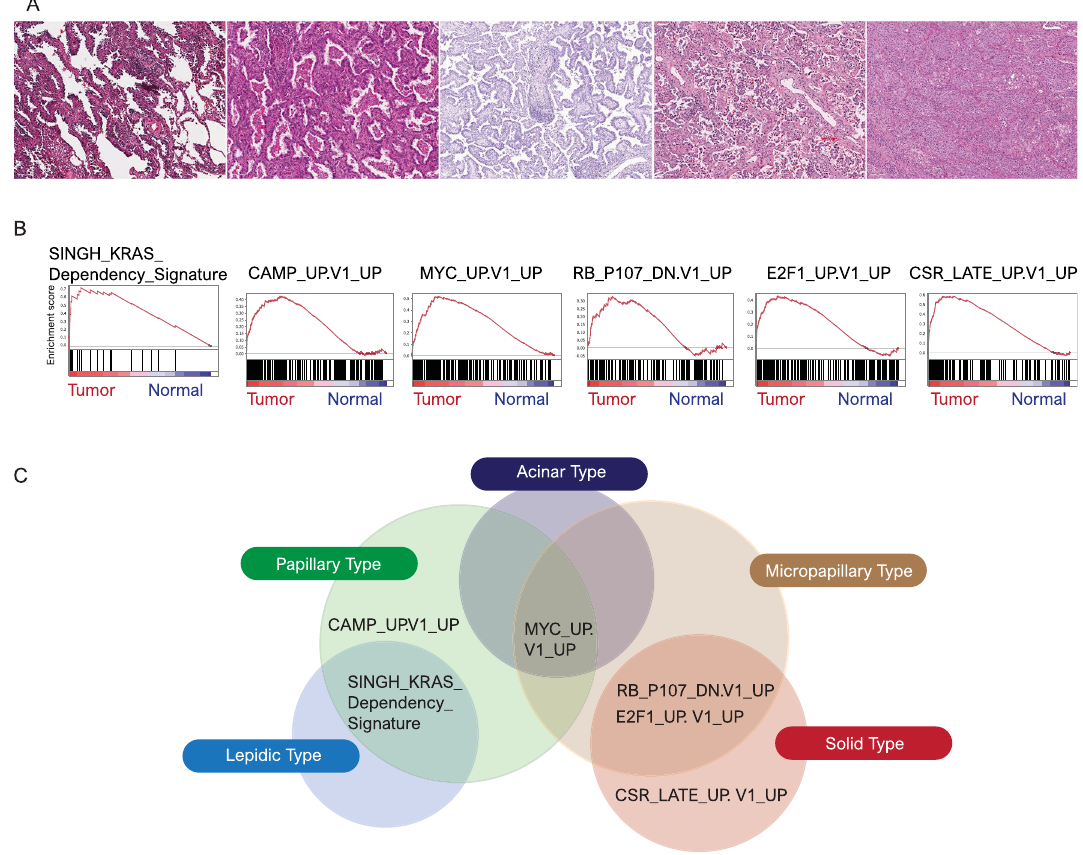
Figure 1. ( A ) Representative histological features showing the lepidic (left), acinar, papillary, micropapillary and solid (right) patterns. ( B ) Six gene sets, including SINGH KRAS Dependency Signature, CAMP UP.V1 UP, MYC UP.V1 UP, RB P107 DN.V1 DN, E2F1 UP.V1 UP and CSR LATE UP.V1 UP, associated with lung adenocarcinoma. ( C ) Venn diagram showing the distribution of gene sets according to the five histological